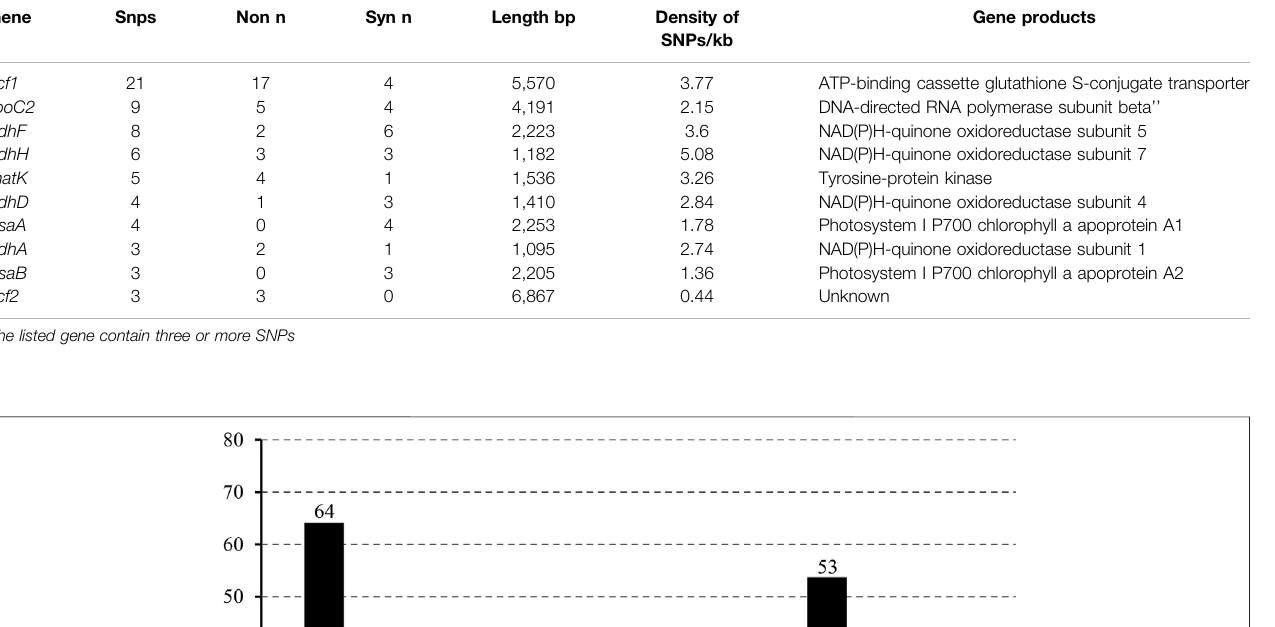
TABLE 4 | Highly single nucleotide polymorphism variable chloroplast protein coding genes of L. cardiaca . Gene